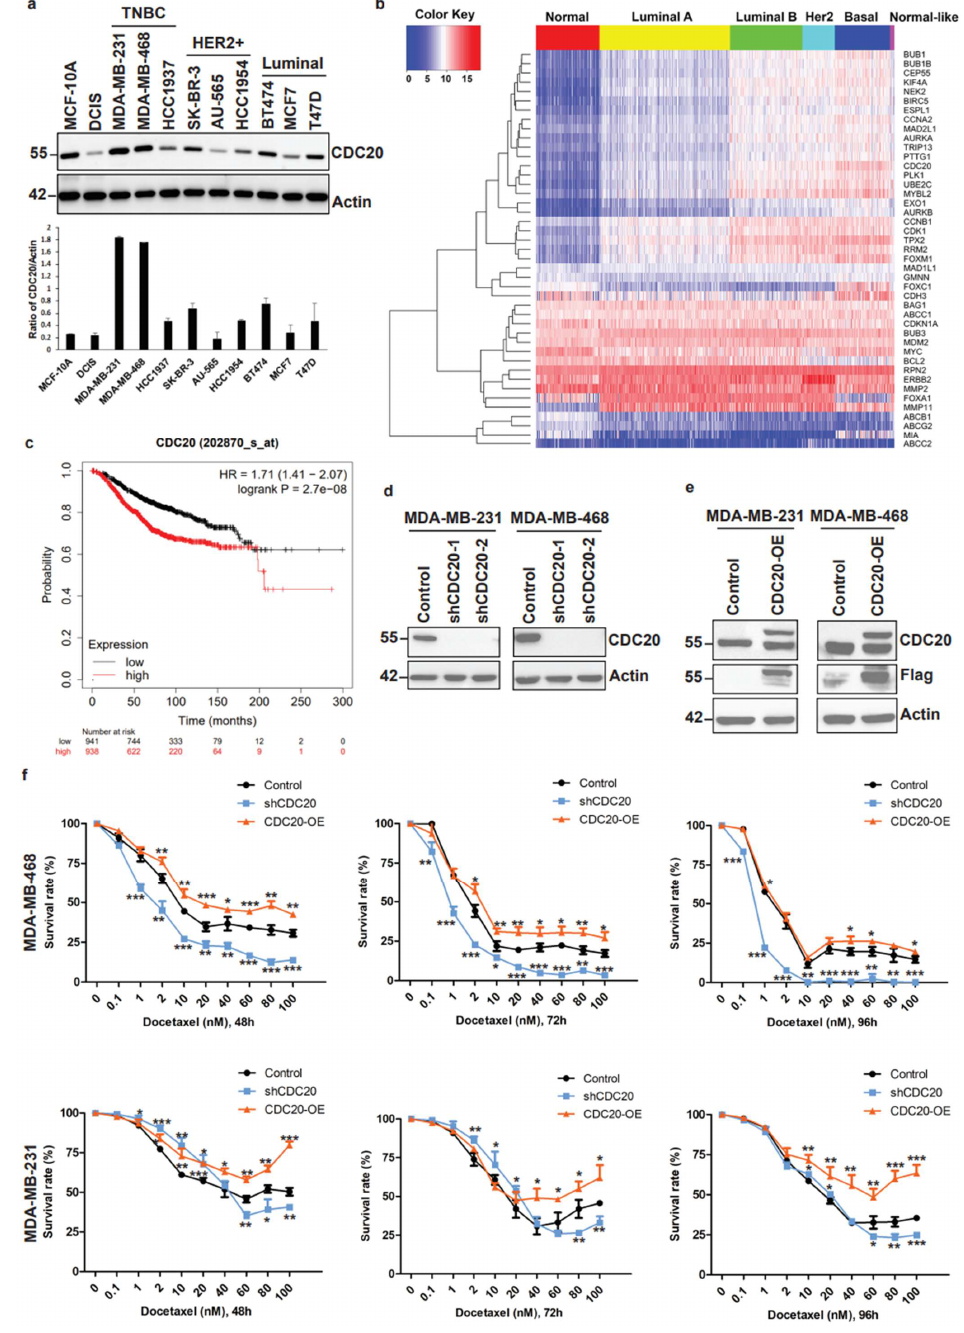
Figure 1. Elevated CDC20 correlates with poor breast cancer prognosis and drug resistance. ( a ) The expression of CDC20 was analyzed by Western blot in the normal breast epithelial cell line (MCF-10A), the ductal carcinoma in situ (DCIS) cell line, and different breast cancer cell lines. ( b ) Heatmap of